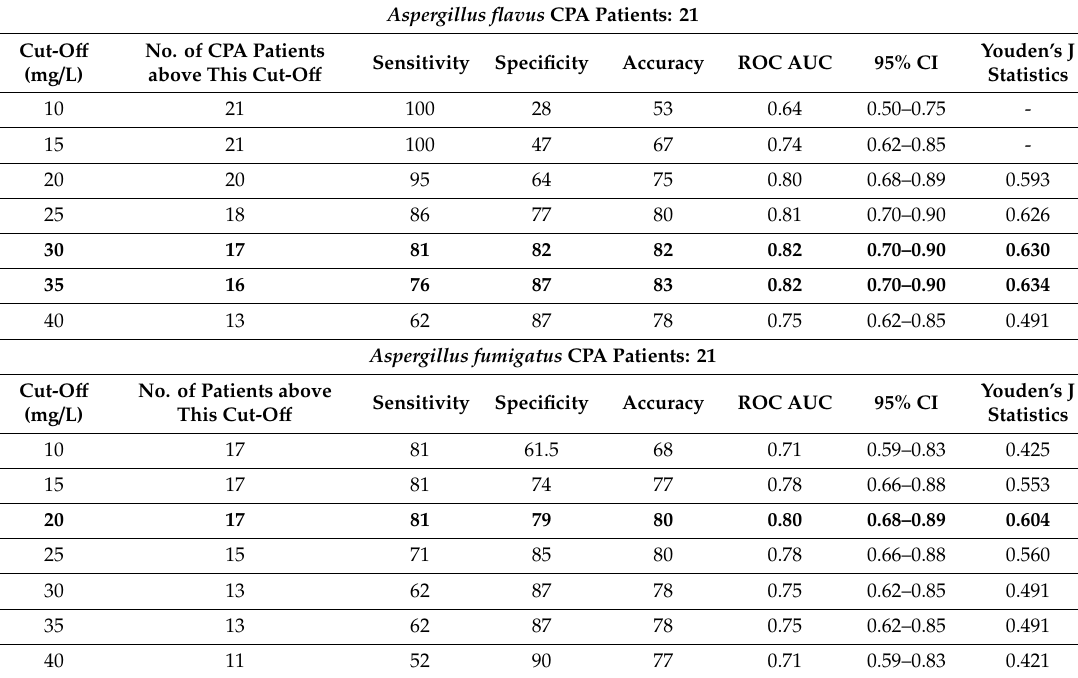
Table 3. Sensitivity, specificity, and accuracy of using di ff erent cut-o ff s for interpretation of Aspergillus IgG in CPA